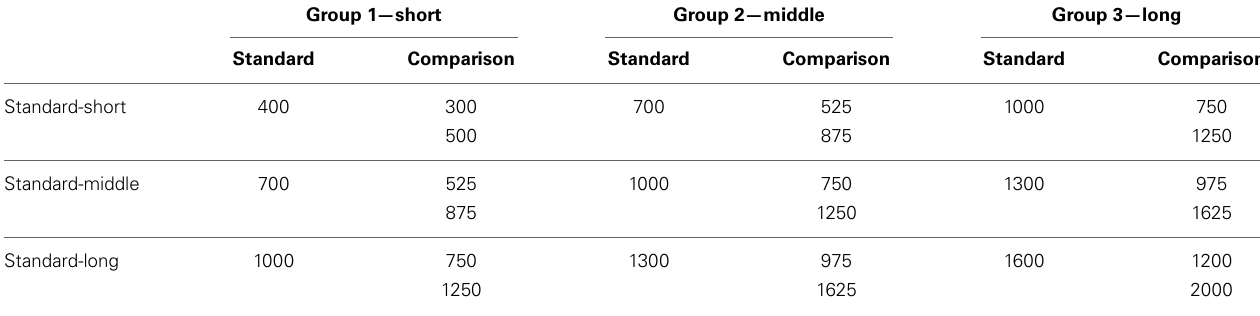
Table 1 | Summary of standard and comparison temporal intervals used in Experiments